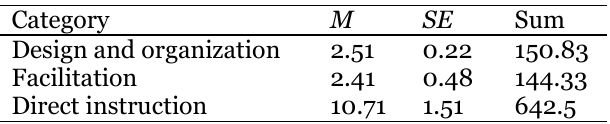
Descriptive Statistics for Teaching Presence